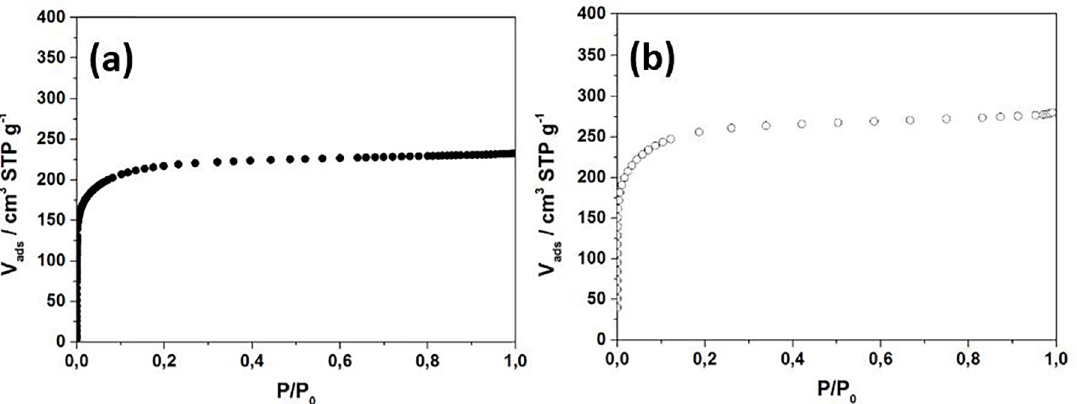
adsorption/desorption isotherms of (a) ACF sample and (b) Ag@ACF sample. Figure 4. N 2 Table 1. Textural properties of the